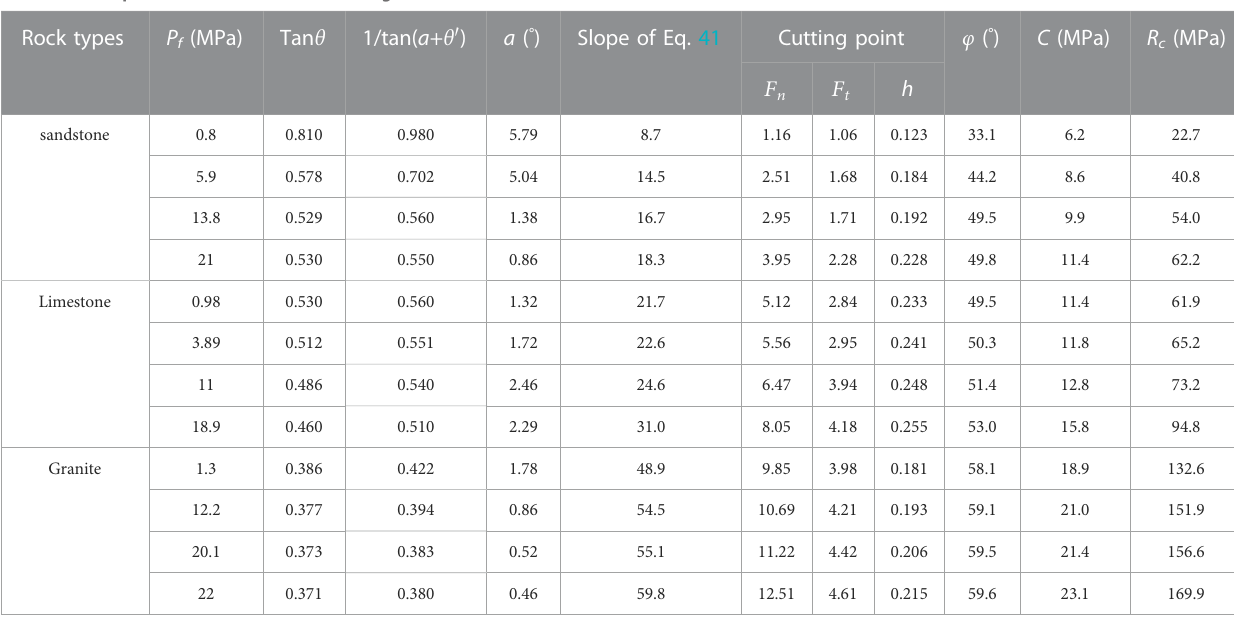
TABLE 1 Rocks parameters obtained from drilling